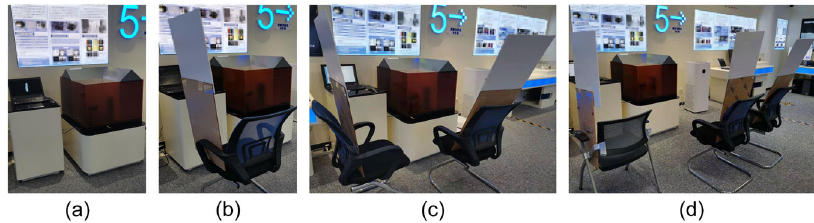
Fig. 3 Occluder-based passive non-line-of-sight recognition system encircled by an L-shaped translucent acrylic plate in different ambient lighting conditions. a Zero, b one, c two, and d three opaque plates of around 1.70 m height placed around the system to cast shadows on the Table 3 Summary of the recognition accuracies of ResNet18 models trained under varying ambient lighting conditions. Model